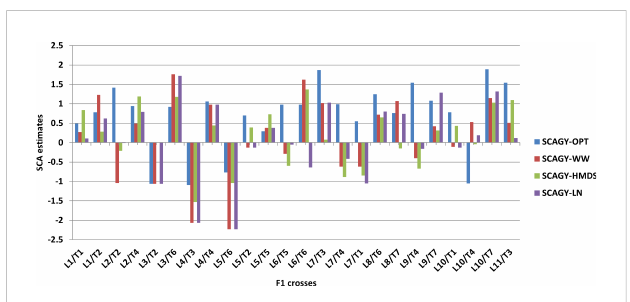
FIGURE 3 Speci fi ccombiningability (SCA)estimatesofsome crosscombinationsfor grainyield(GY)underoptimum, well-watered, managedheat anddrought stressandlowNconditions. OPT, optimumconditions;WW,well-watered; HMDS, heat